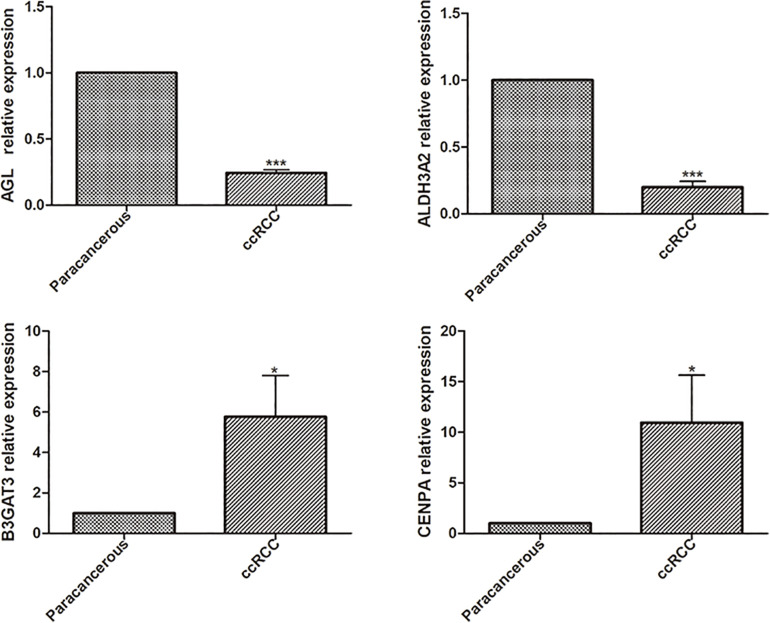
The differential expressions of the four glycolysis-related mRNAs were detected in paracancerous and ccRCC tissues by qPCR (*p < 0.05; **p < 0.01; ***p < 0.001).